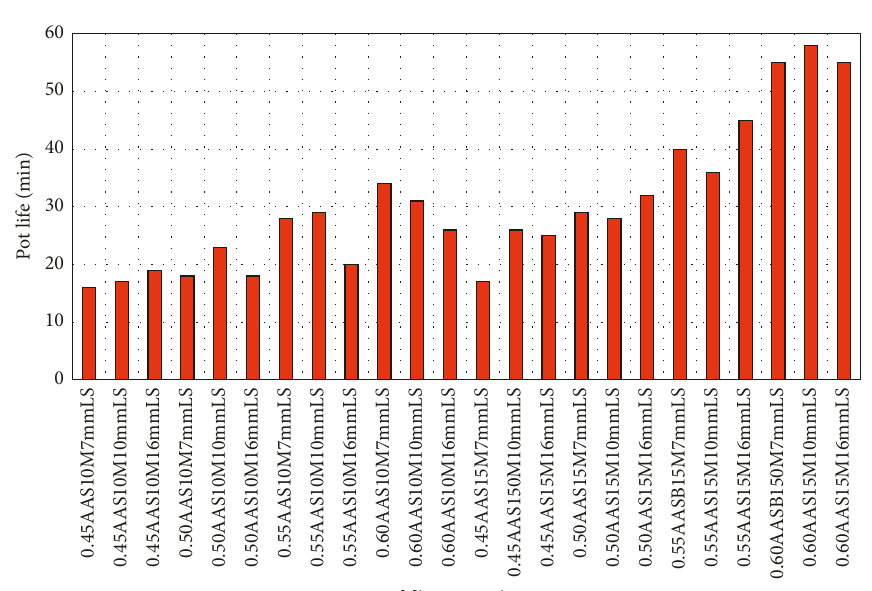
Figure 6: Pot life of the